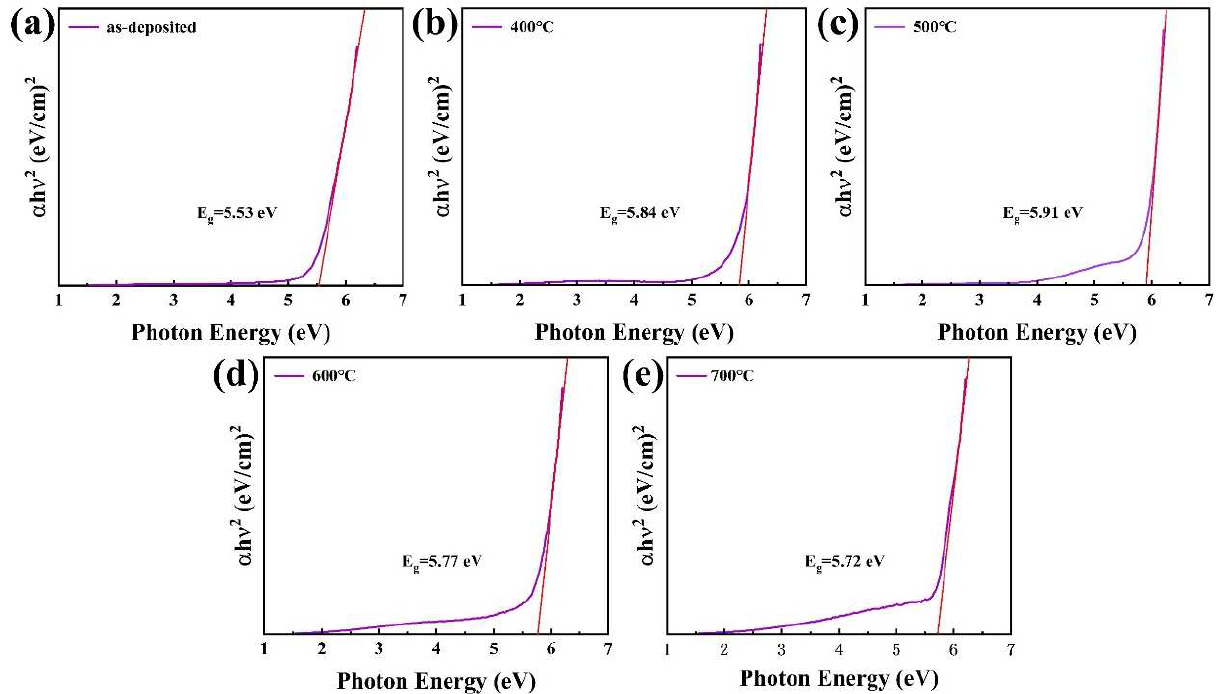
Figure 10. ( a – e ) Band gap values of lanthanum-doped HfO 2 films at different temperatures.